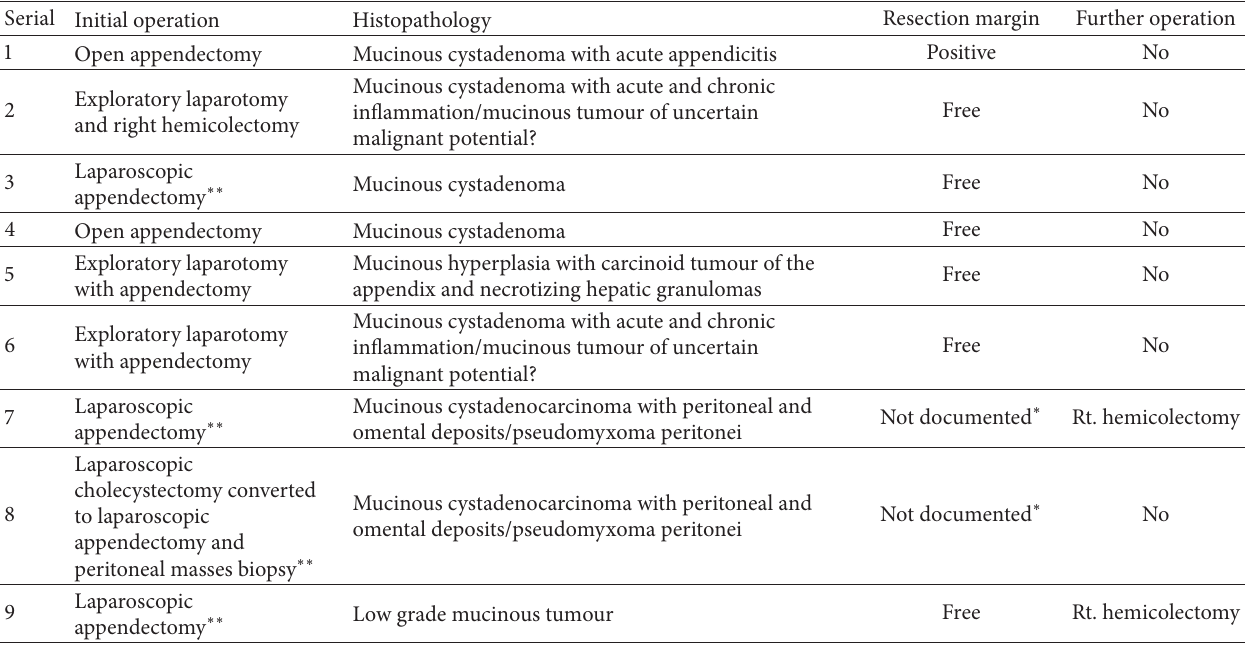
Table 3: Initial operation and histopathologic diagnosis, margin status, and further operation.